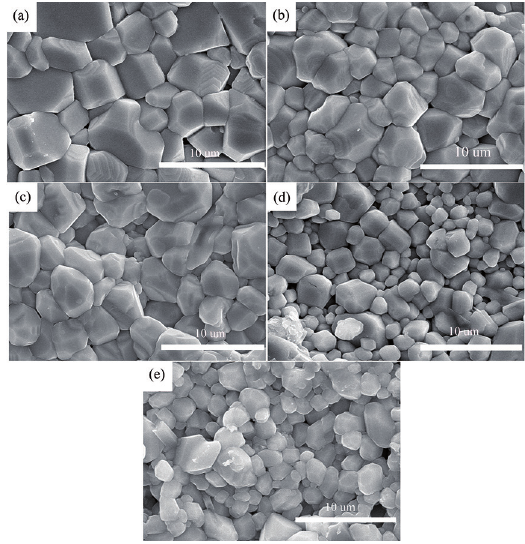
Figure 6: Surface SEM images of BZT10 ceramics sintered at 1300 o C/2 h (a) 0 mol%, (b) 0.1 mol%, (c) 0.3 mol%, (d) 0.5 mol%, (e) 0.7